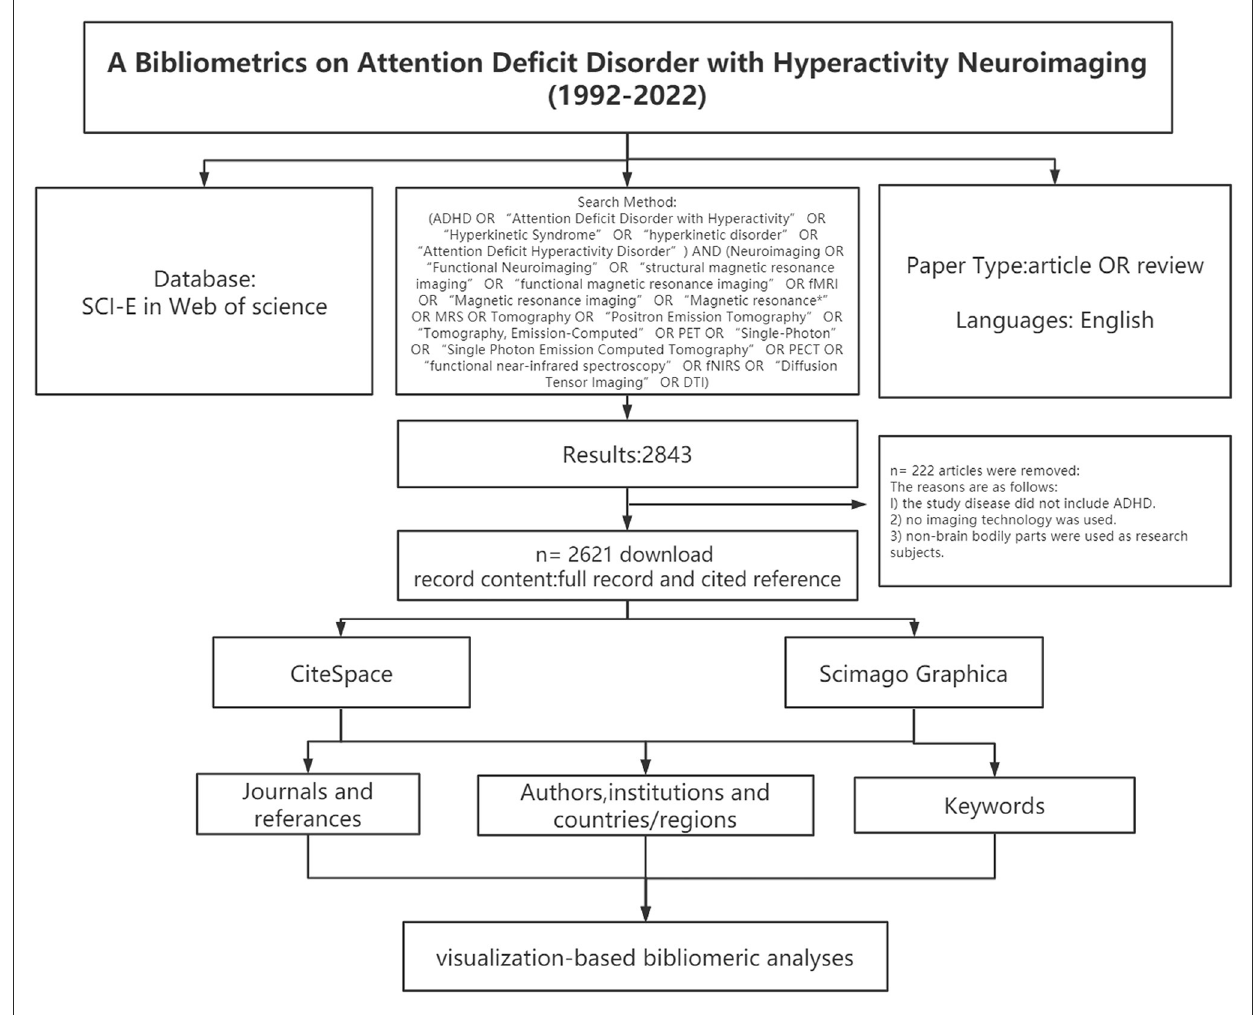
FIGURE1 Frame flow diagram shows the detailed selection criteria and bibliometric analysis steps of ADHD neuroimaging.